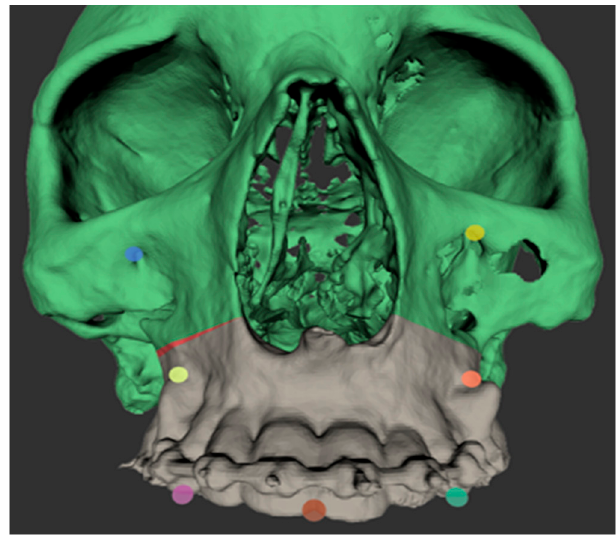
Figure 4. Screenshot of the registration points used for point-based registration of the patient’s skull to the digital model imported into the software of the CARLO® device. The osteotomy line on the right maxilla can be adjusted intraoperatively directly in the software of the CARLO® device; the adjustment made is shown in red.